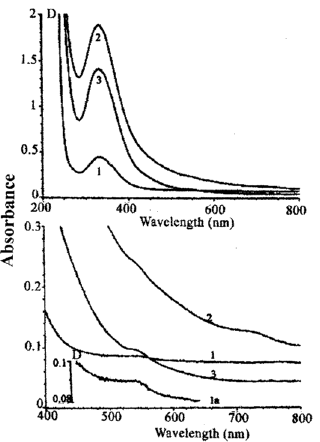
Figure 17. The absorption spectra of GS-NO formed after adding glutathione to the solution of decomposed M-DNIC-H 2 O. Curves 2 and 3—GS-NO spectra registered immediately, and in 5 min after adding glutathione (with pH = 1–2) to the solution of M-DNIC-H 2 O decomposed in 20 min after pumping NO out of the Thunberg apparatus. Curves 1 and 1a—the absorption spectra of GS-NO formed in water due to the presence of some NO 2 in gaseous NO. Water was treated with NO without adding divalent iron (control experiments) [87]. (With permission).